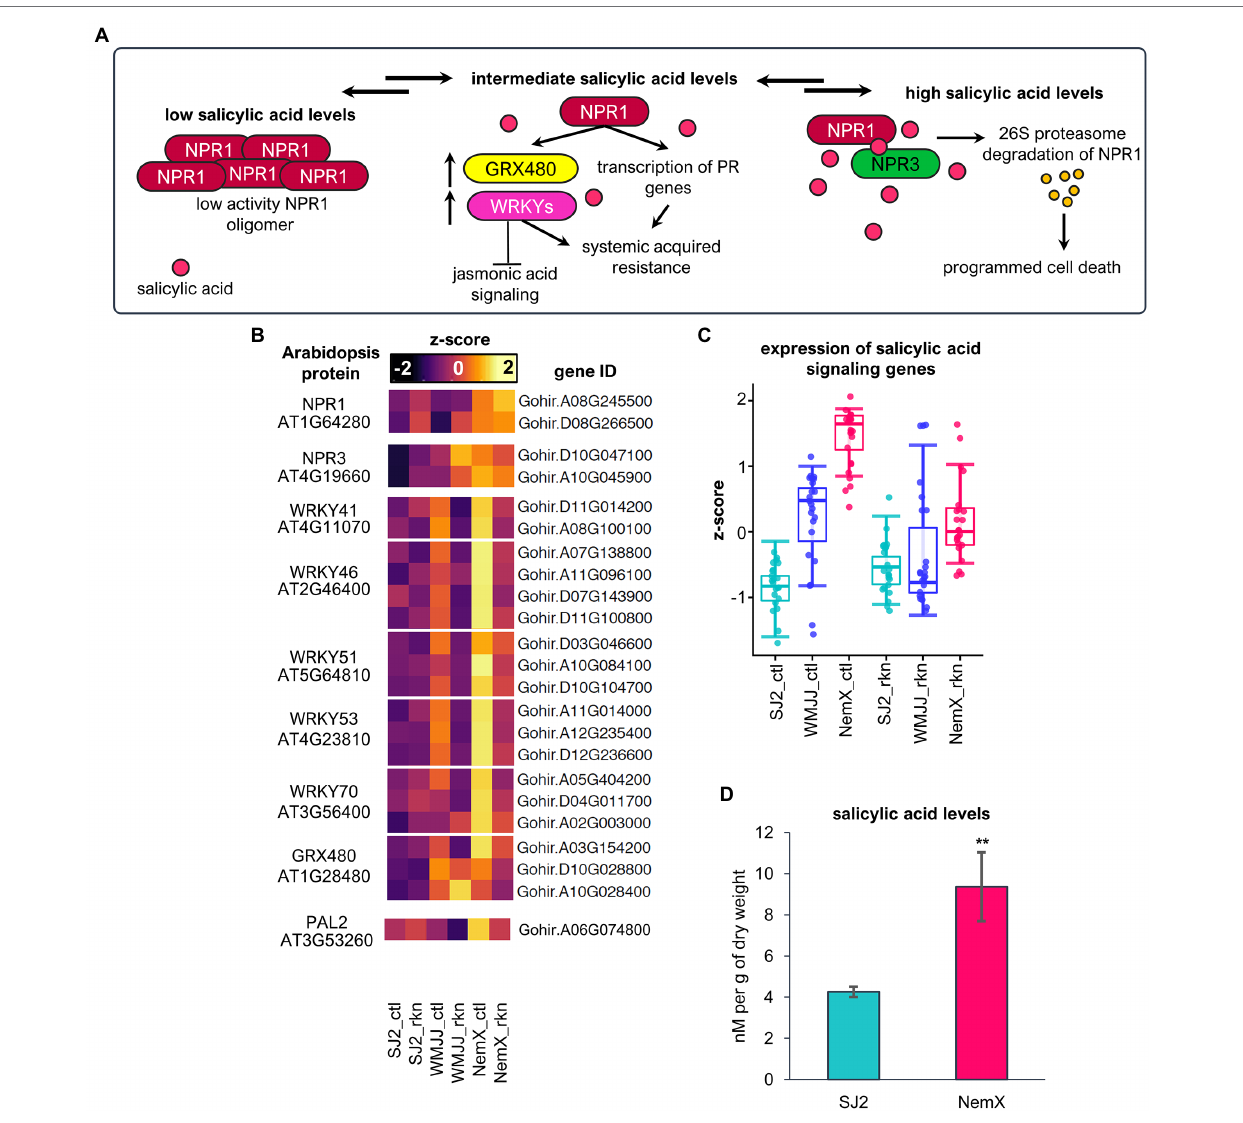
FIGURE 6 | Basal expression of salicylic acid signaling genes is upregulated in NemX and in WMJJ to an intermediate extent, with respect to SJ2. (A) Salicylic acid signaling in Arabidopsis. (B) Heatmap of the relative expression of Gh genes coding for orthologous proteins of Arabidopsis. (C) Boxplot analysis of the expression levels of salicylic acid synthesis genes presented in (B) . (D) Quantification of salicylic acid in SJ2 and NemX cotton plants using UHPLC coupled to MS. Salicylic acid levels were determined in nanomoles (nM) per gram of dry weight. Student t -test was performed to determine statistically significant differences ( n = 3) which are indicated with two asterisks ( p <